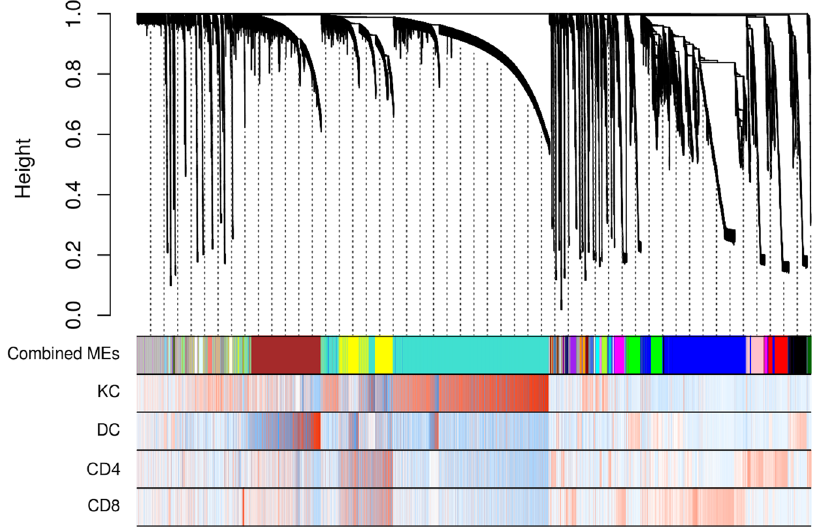
Figure 4. Cluster dendrogram reveals modules that were positively correlated with a specific cell type. Hierarchical clustering dendrogram of modules identified by WGCNA with branches corresponding to module color assignments in the first color band beneath the dendrogram. The remaining color bands show how positively (red) or negatively (blue) an individual gene is correlated with a specific module and cell type.